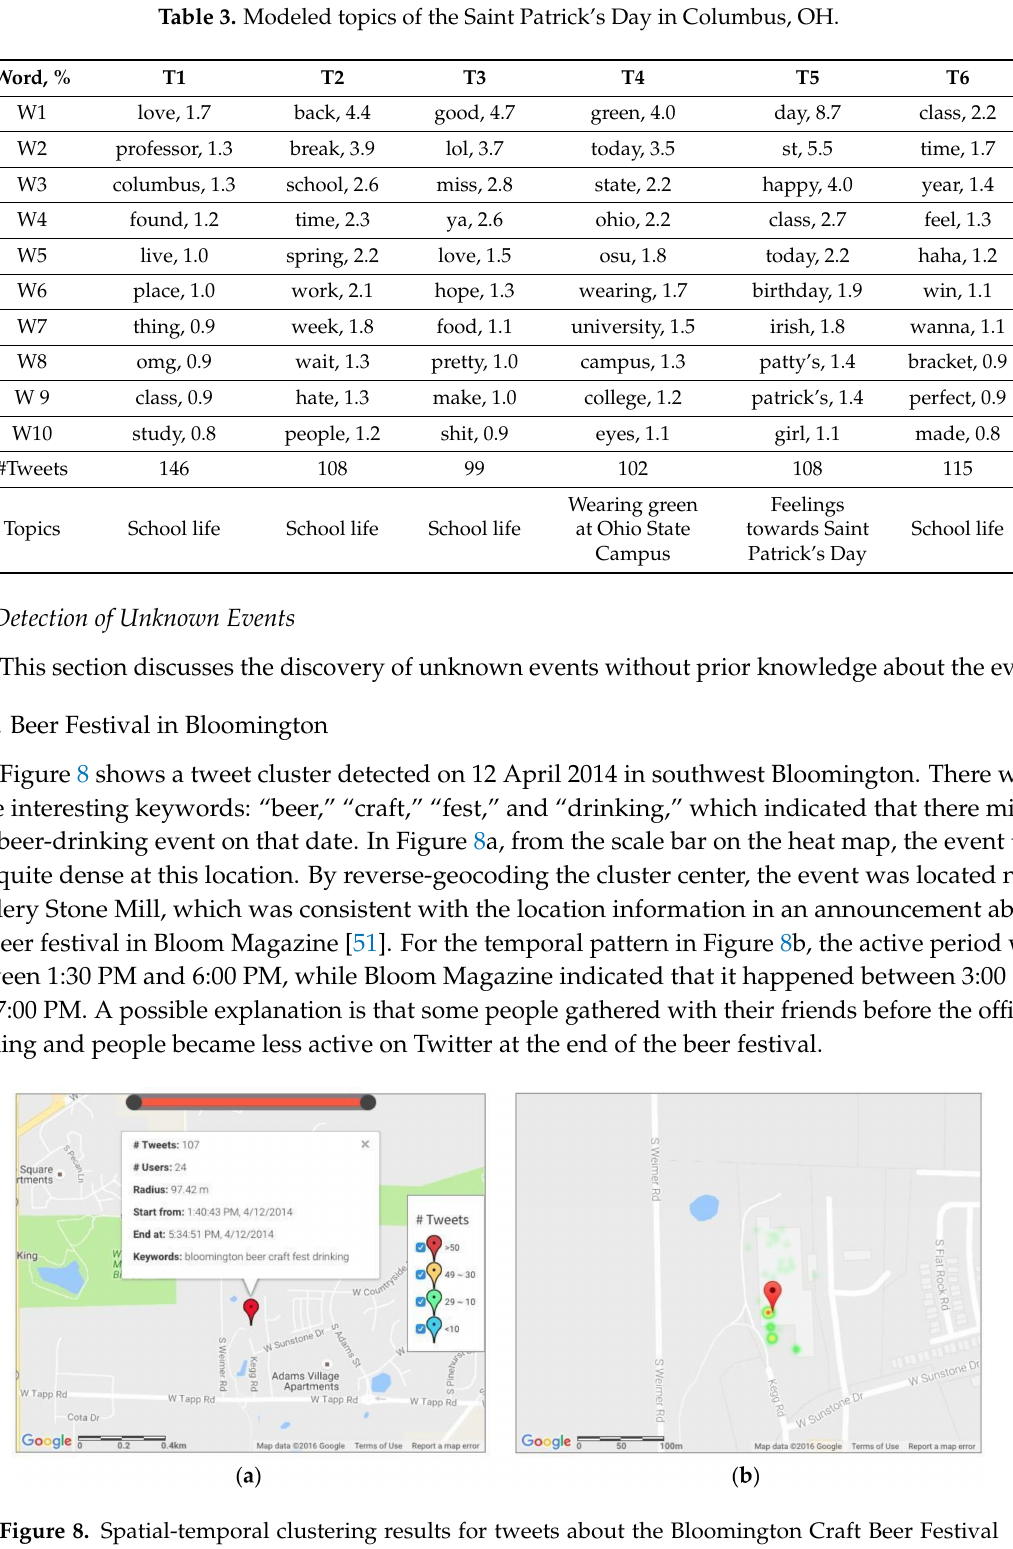
Table 3. Modeled topics of the Saint Patrick’s Day in Columbus, OH.